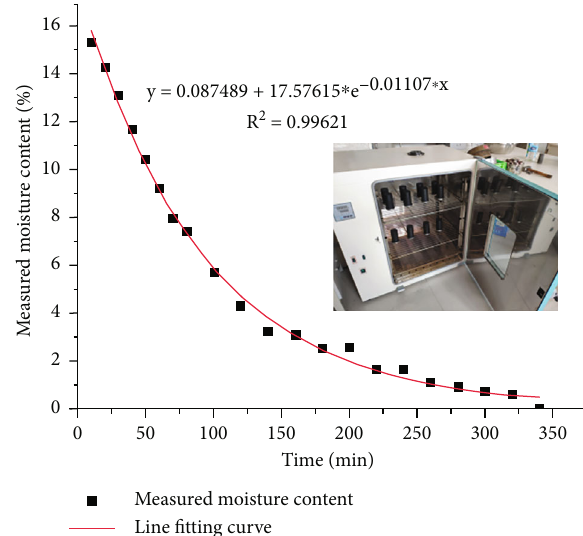
Figure 6: Variation curve of moisture content of coal sample with drying time.